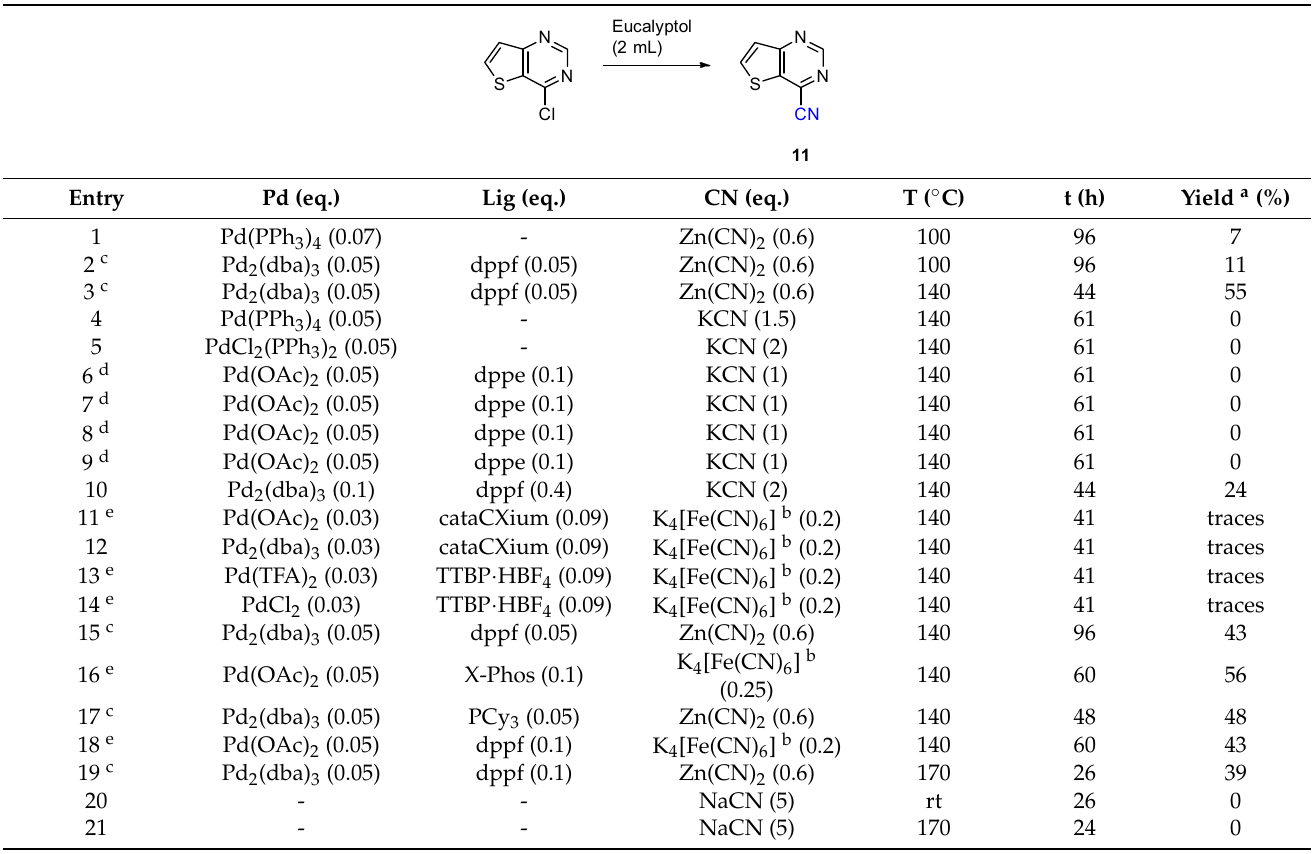
Table 2. Optimization of cyanation.